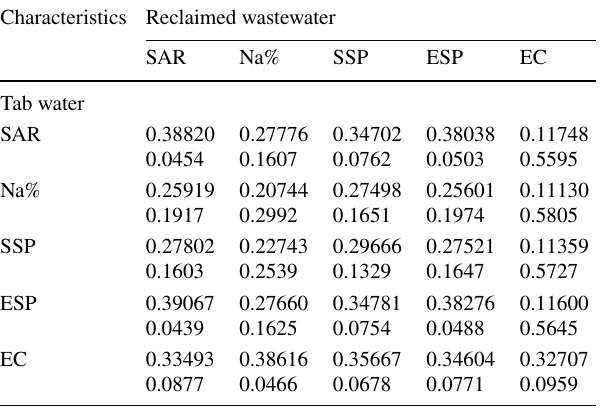
Table 6 Correlation matrix between reclaimed wastewater and tap sample